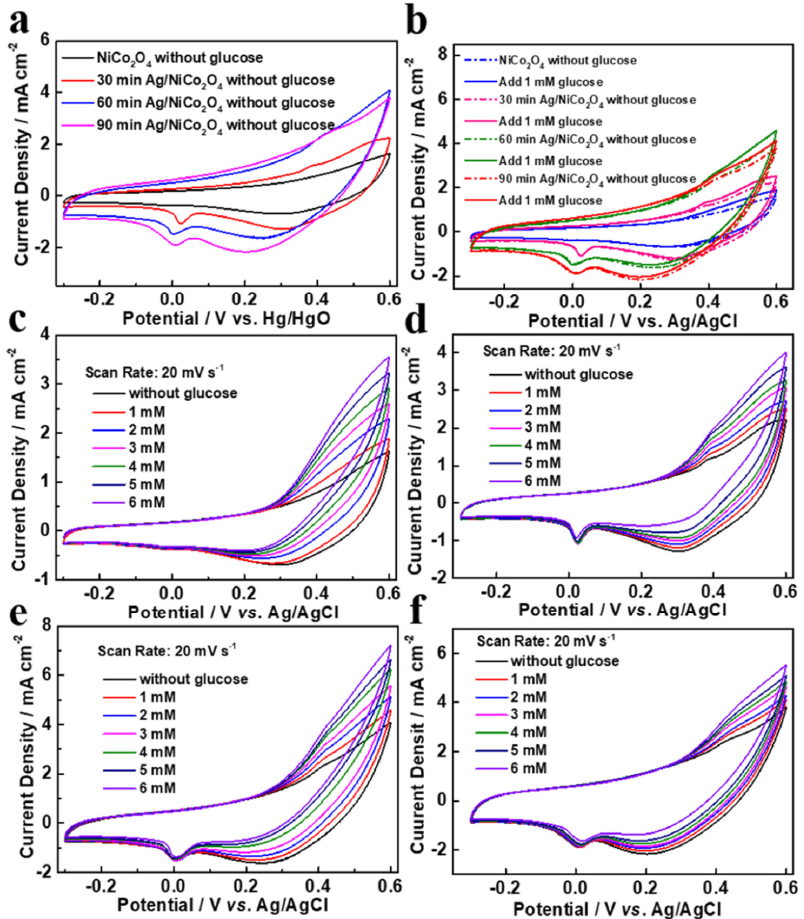
Figure 5. CV curves of different samples in ( a ) 0.1 M NaOH, ( b ) 0.1 M NaOH + 0.1 mM glucose at a scan rate of 20 mV s −1 , ( c ) NiCo 2 O 4 -NC, ( d ) Ag/NiCo 2 O 4 -NC-30, ( e ) Ag/NiCo 2 O 4 -NC-60 and ( f ) Ag/NiCo 2 O 4 -NC-90 in 0.1 M NaOH and 1–6 mM glucose.